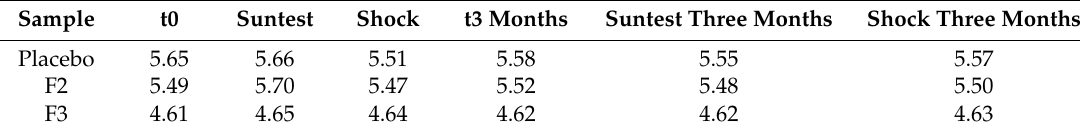
Table 8. pH values of formulations before and after treatments and after three months.